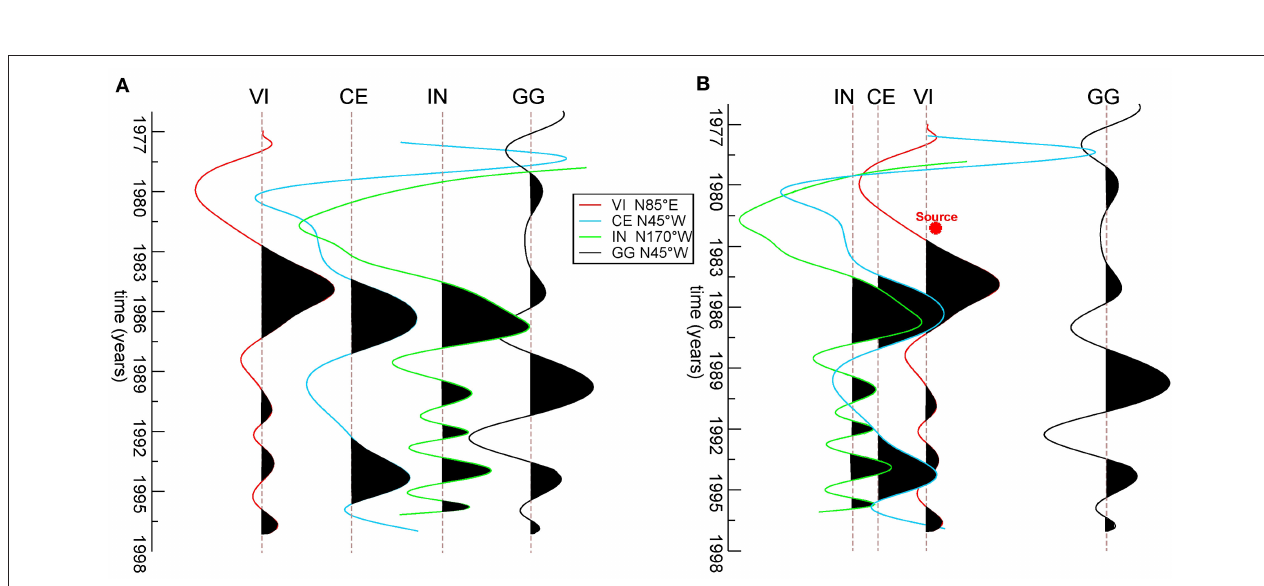
FIGURE 8 | IMF8 for the four stations, in a variable area mode (black area: the positive signal), in the direction in which the transient is maximum and positive. A gain of 10 4 is applied to the GG signal to allow comparison with the other stations. Vertical axis: time (years). (A) The time series for each station is ordered following the uprise times, with trace interval fixed. (B) The trace interval is proportional to the distance from the calculated source (red star). The traces located to the west of the source of the transient (red star) are on the left, while GG, to the east of the source, on the right.